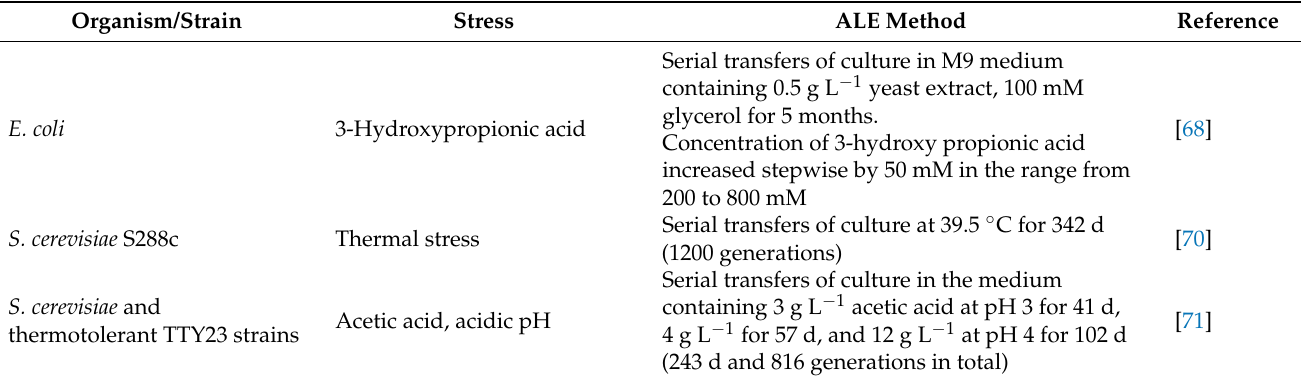
Table 3. Recent ALE studies for conferring stress tolerance to E. coli and S. cerevisiae .